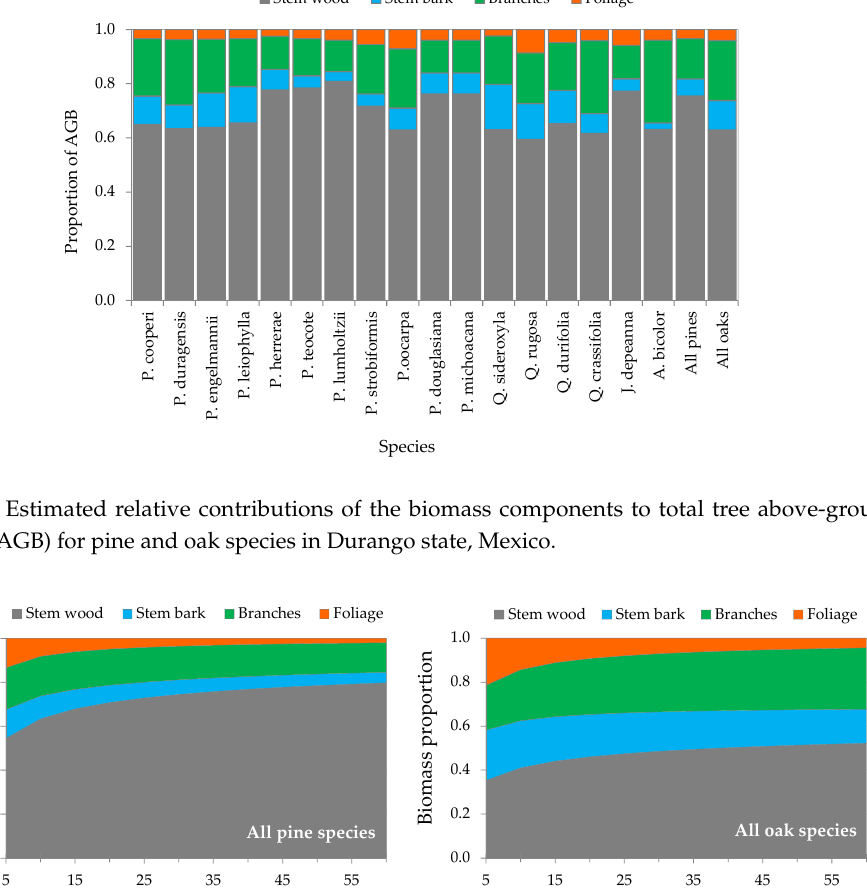
Table 3. Specific mean carbon contents of the main tree components of pine and oak species in the study (standard deviation is given in brackets).